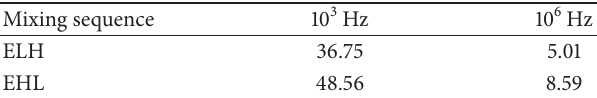
Table 1: Dielectric constant value of porous epoxy at 10 3 and 10 6 . Mixing